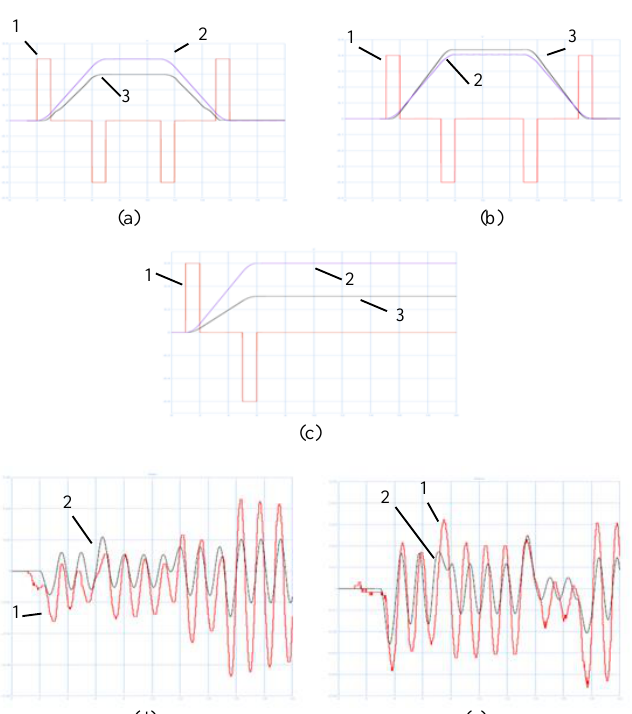
(e) Fig. 3. The 3D Crane state-space representation and Inteco ® model simulation Fig. 5. 3D Crane fuzzy logic control system: r x , r y and r z – reference X , Y and Z -axes positions; x , y and z – real X , Y and Z -axes positions, β – X -axis angle;